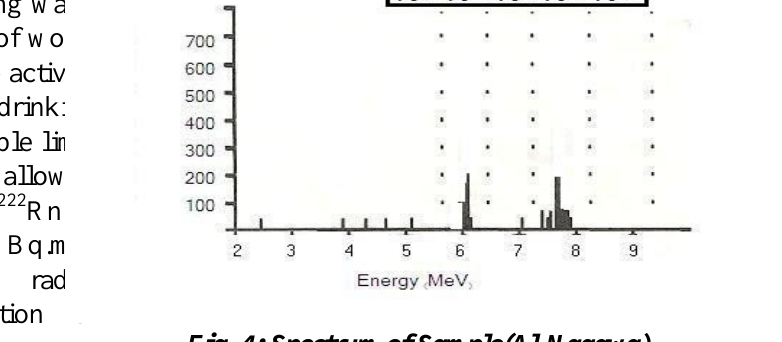
Fig. 4: Spectrum of Sample(Al-Naqawa)